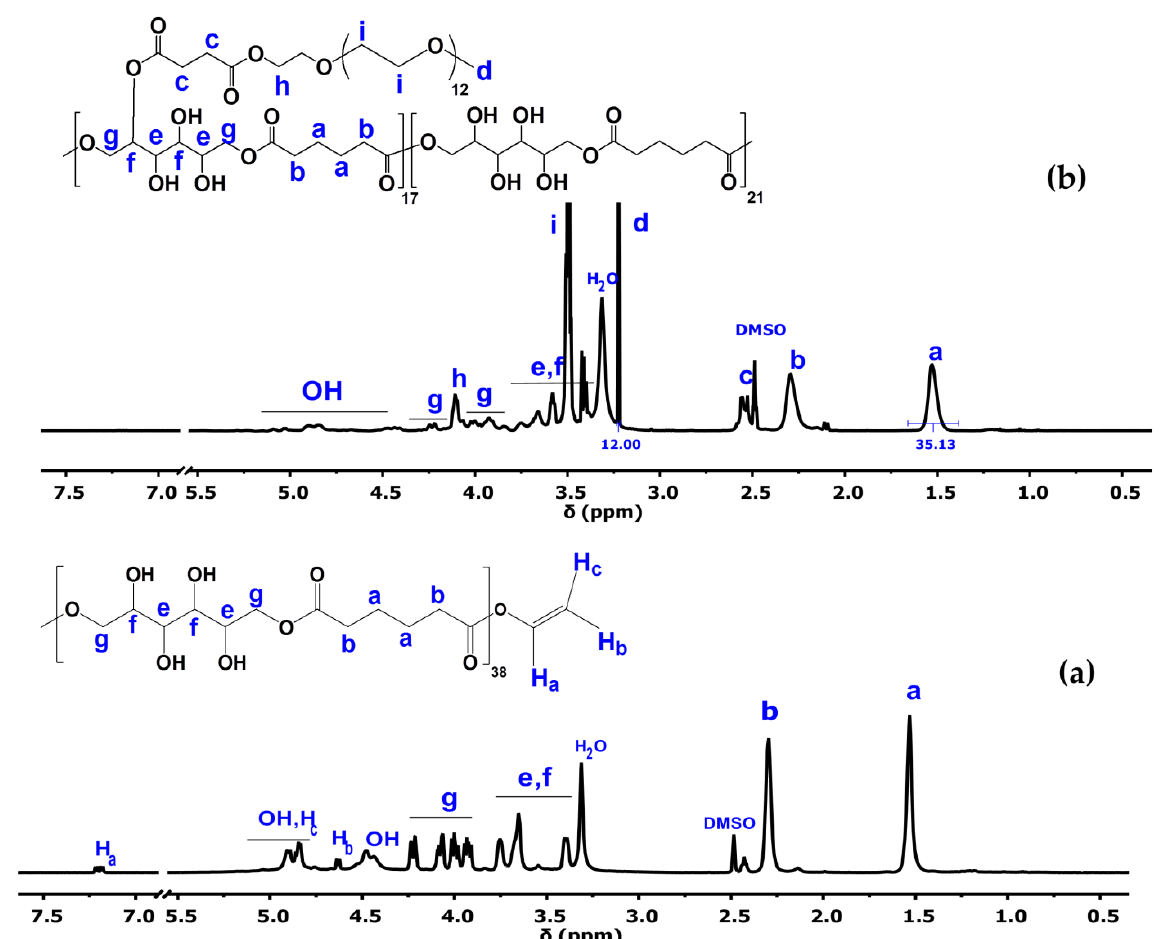
Figure 1. 1 H NMR spectra of ( a ) PSA (poly(sorbitol adipate)) and ( b ) PSA- g -mPEG 12 measured at 27 °C using DMSO-d 6 as solvent.